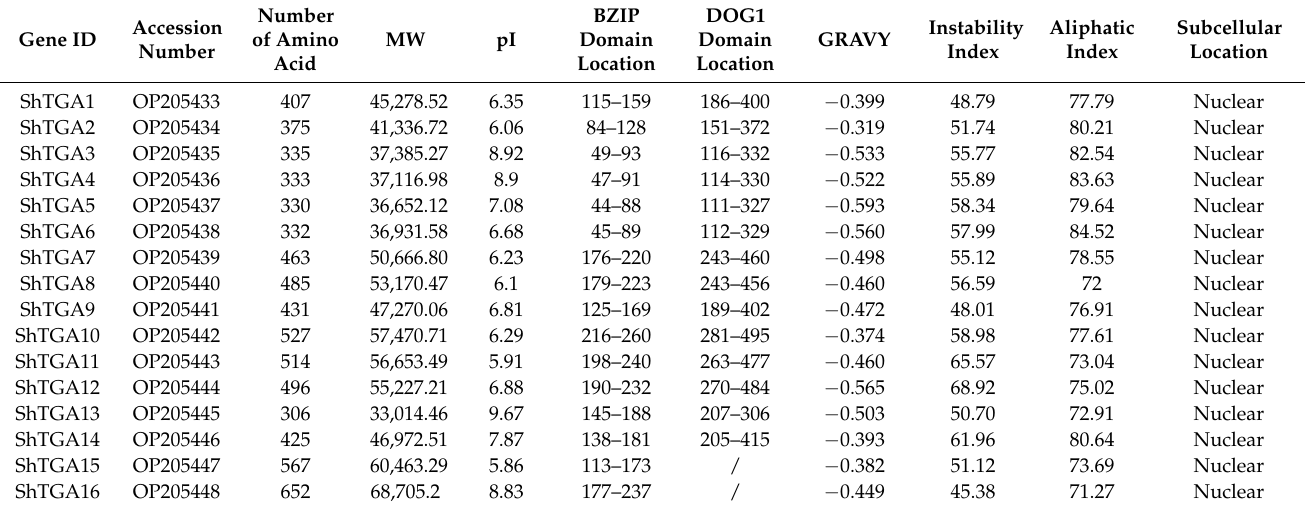
Table 1. Physico-chemical parameters and subcellular predictions of TGA family members in Saccha- rum spp.